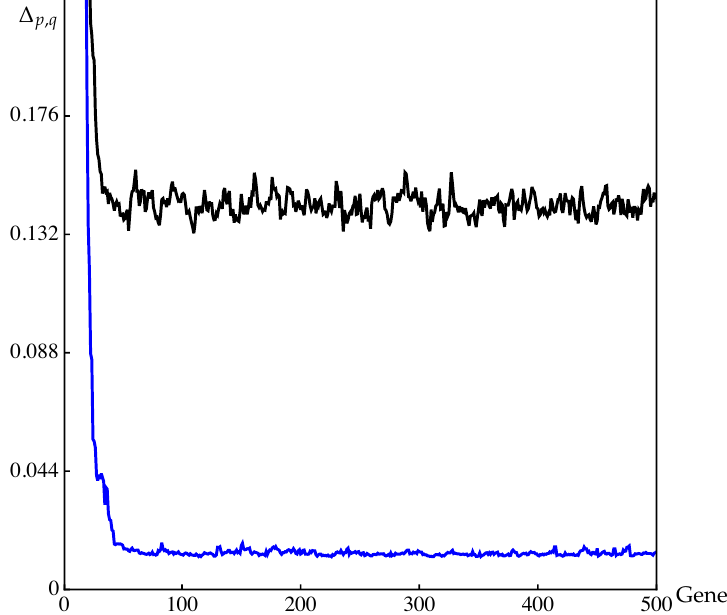
Figure 14. ∆ p , q values for the discrete (black curve) and the continuous archives (blue curve) of NSGA-II for MOP (14).